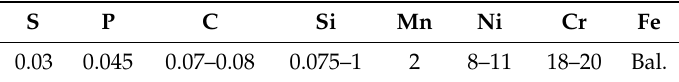
Table 1. Chemical composition of stainless steel (wt